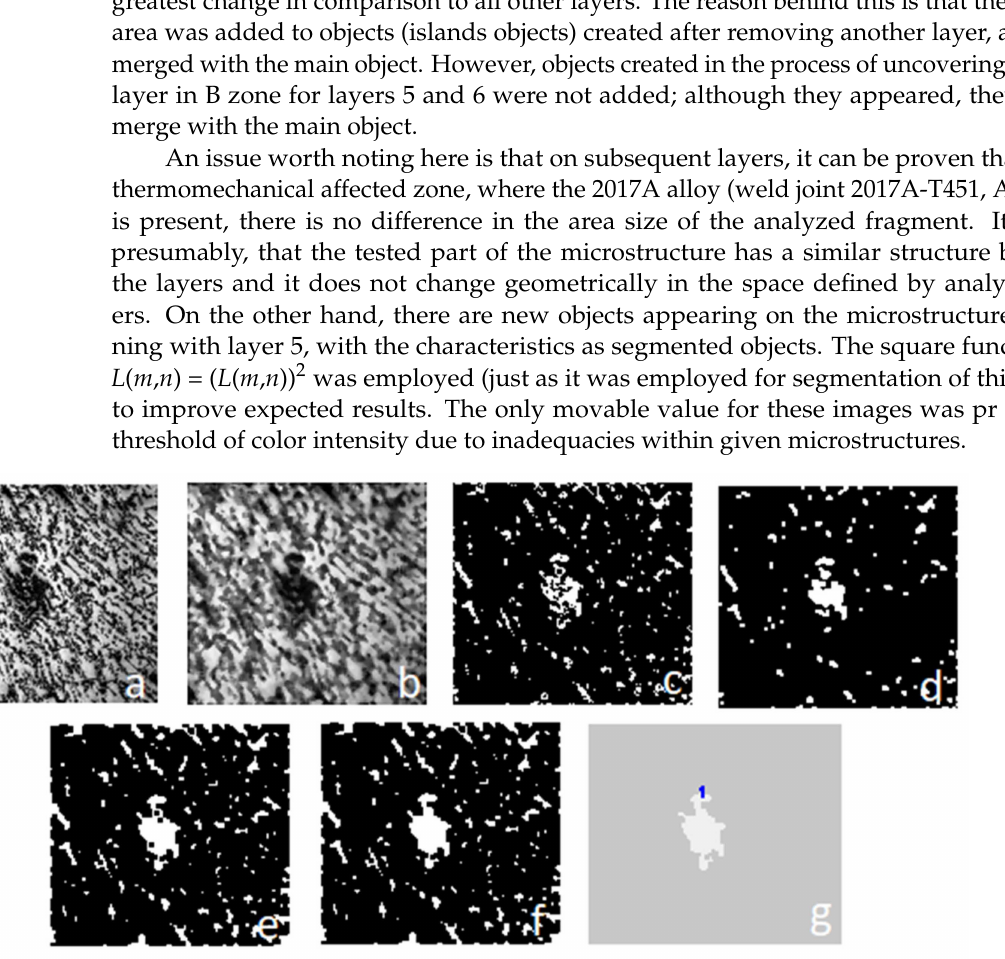
Figure 12. Stages of the object segmentation: ( a ) histogram adaptation and equalization; ( b ) median filter; ( c ) binarization using multi thresholding; ( d – f ) morphological operations, including opening and closing; ( g ) segmented area with the marked